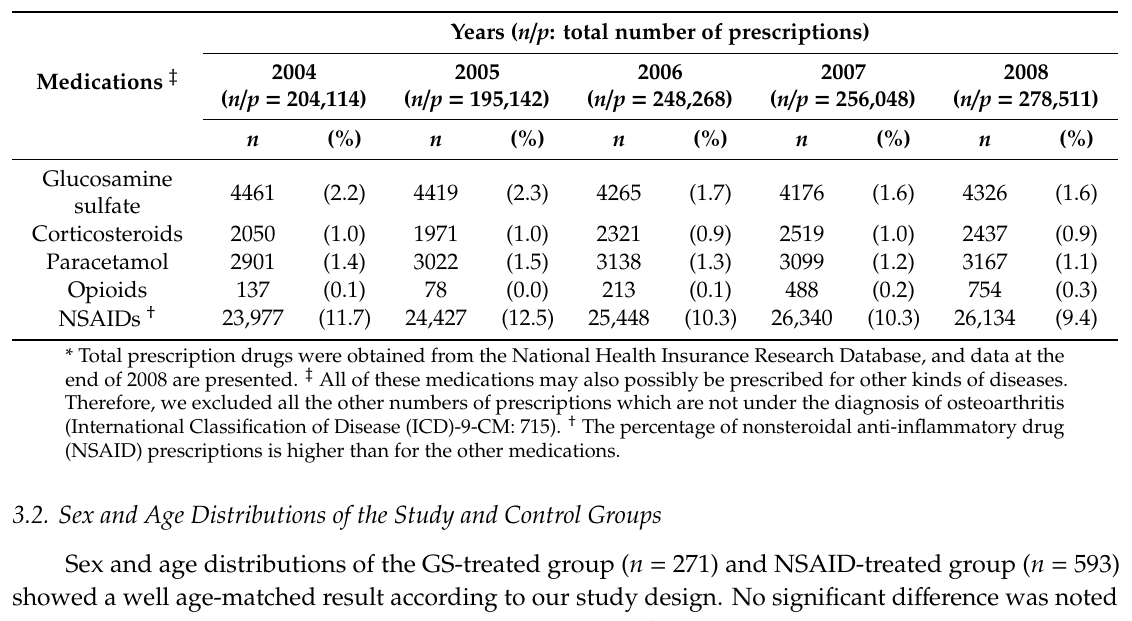
Table 1. Prescription drugs and frequency * for the treatment of osteoarthritis in outpatient Clinics from 2004 to